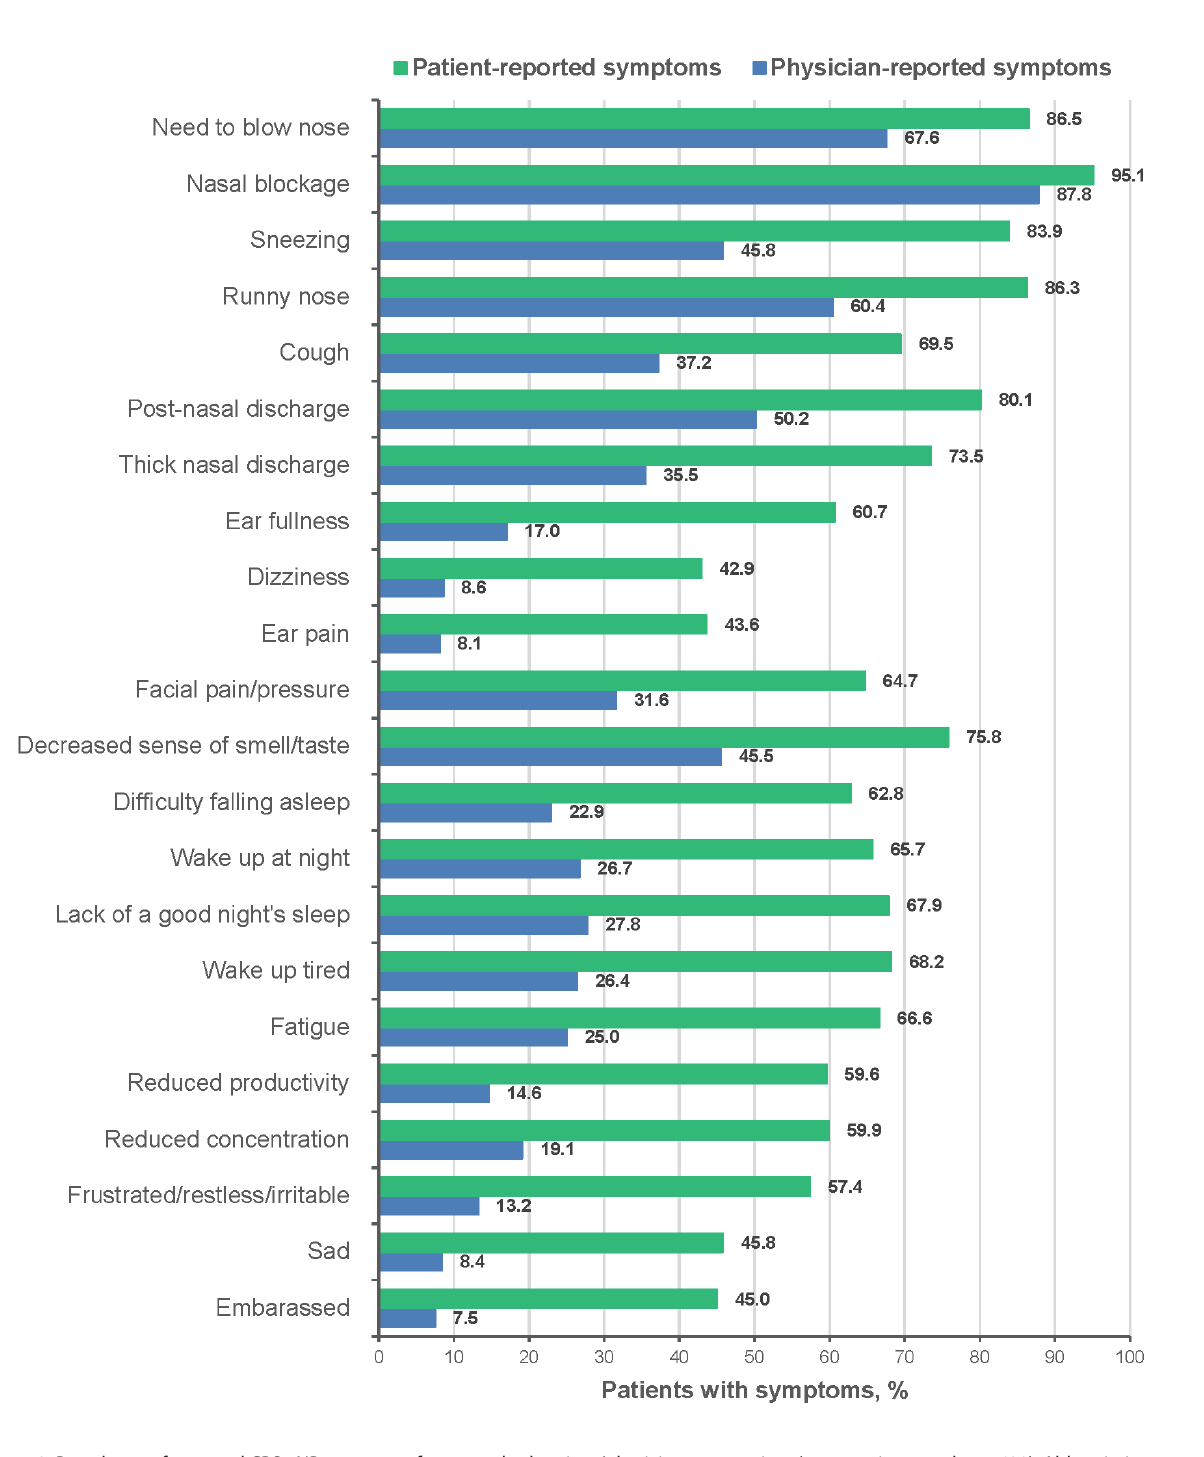
Figure 2. Prevalence of reported CRSwNP symptoms from matched patient/physician perspectives (consecutive sample, n=629). Abbreviation: CRSwNP, chronic rhinosinusitis with nasal